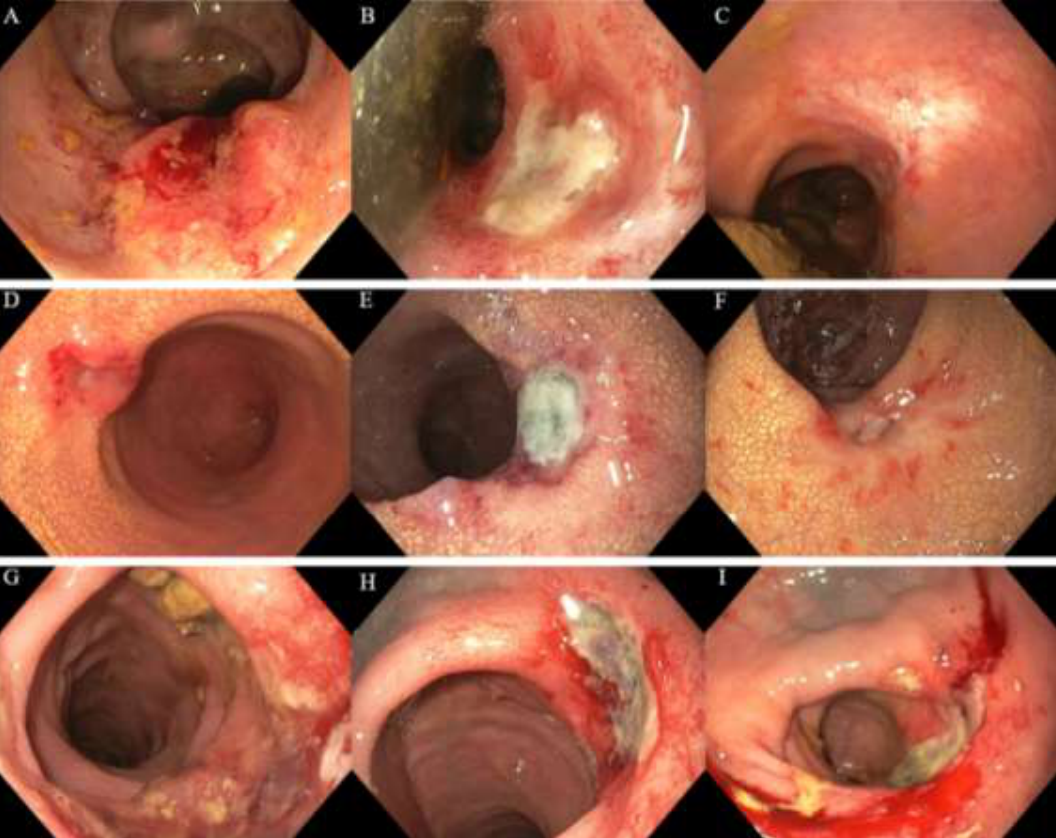
Figure 2. Endoscopic responses following contact X-ray brachytherapy of three patients. ( A ) Regrowth following chemoradiotherapy (50 Gy/25 fractions) for a cT3N0M0 rectal tumor before contact X-ray brachytherapy; ( B ) partial response showing a deep ulcer three months following contact X-ray brachytherapy (90 Gy/3 fractions); ( C ) endoscopic complete